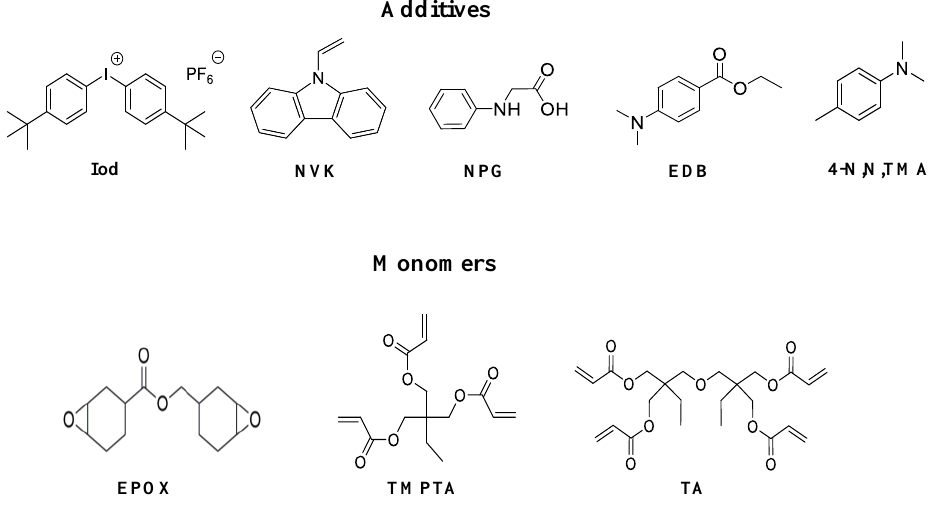
Figure 2. Other organic compounds used.